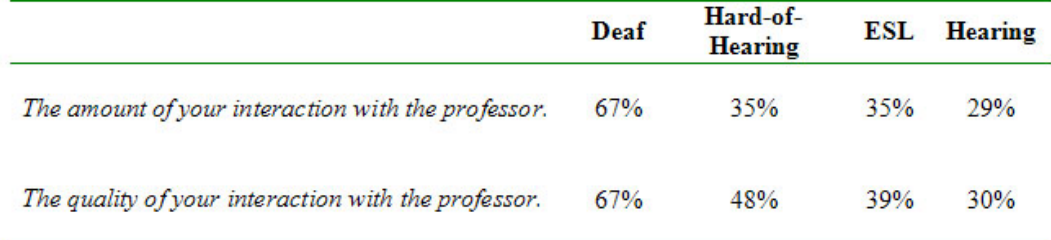
Table 3. Increased Communication with